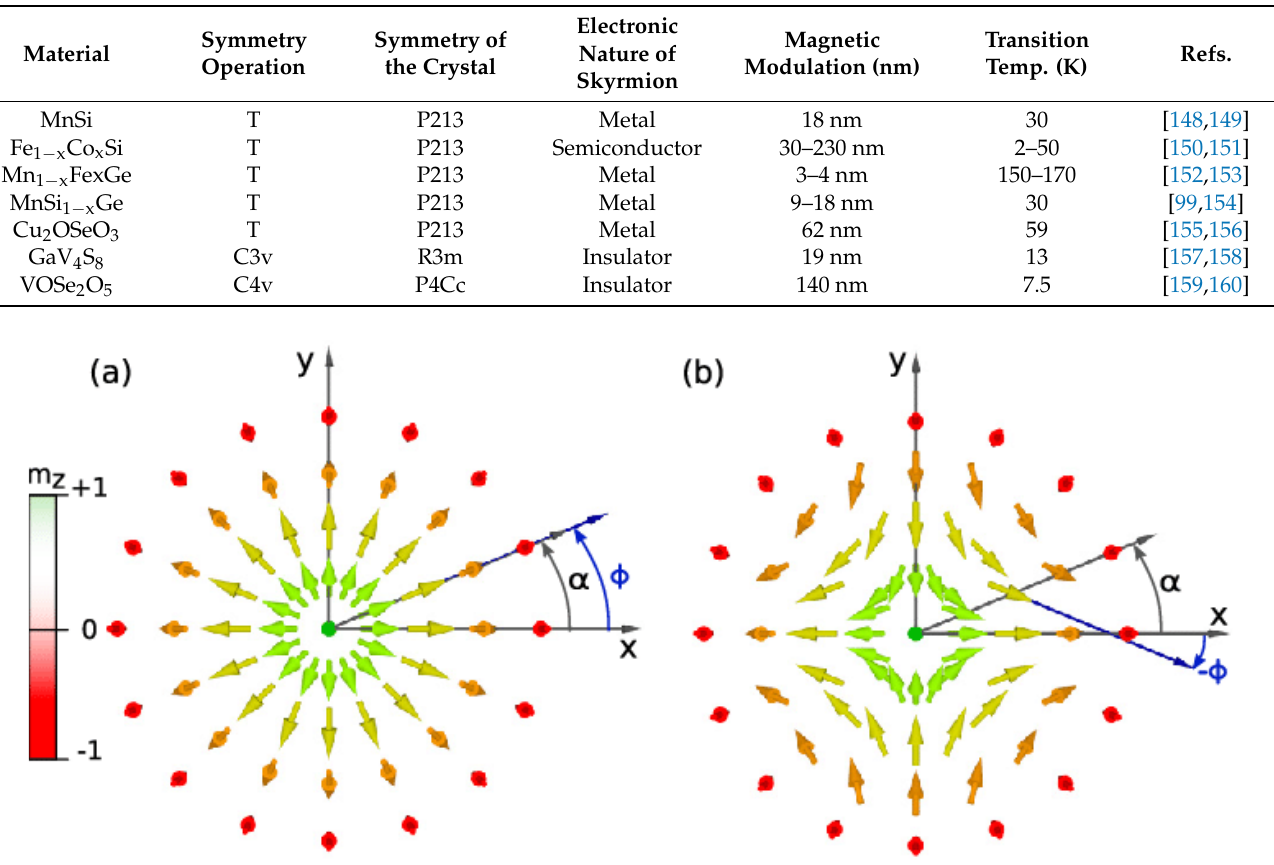
Figure 13. Graphical representation of ( a ) magnetic skyrmion and ( b ) anti- magnetic